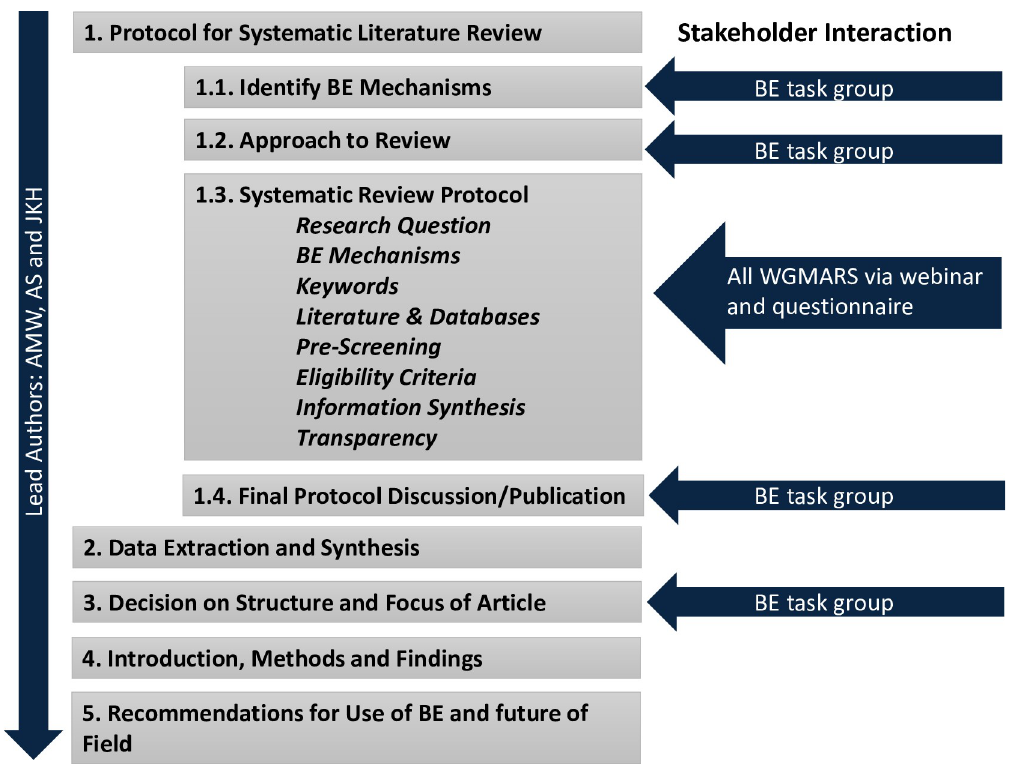
Fig 1. Flow chart depicting the design of the systematic review, indicating the moment where input from the BE task group and WGMARS members was solicited.